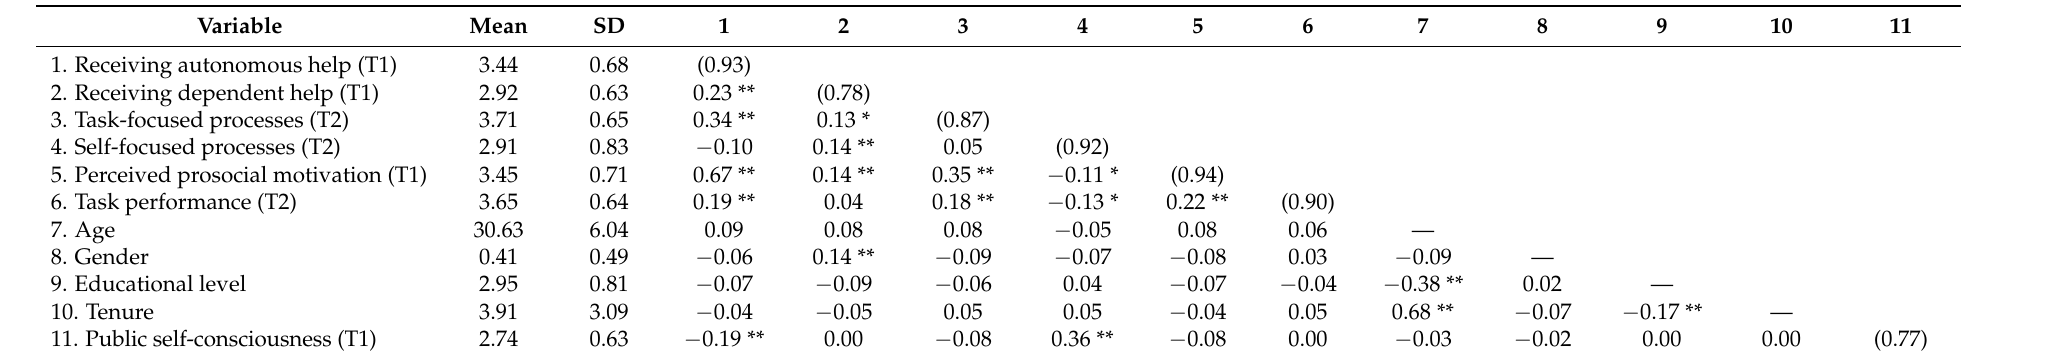
Table 2. Means, Standard Deviations, and Correlations among Variables.